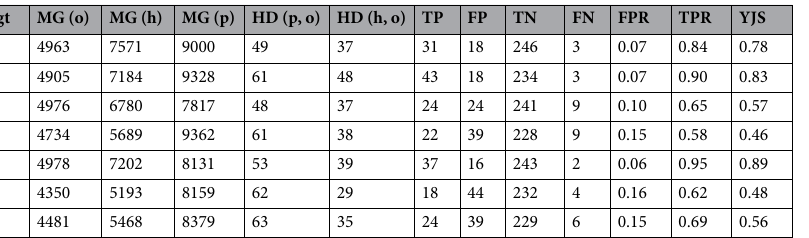
Table 2. Comparison between original, simulated and experimentally humanized sequences. Column 2, 3 and 4 report the MG-score for the original murine sequence “o”, the experimentally humanized sequence “h”, and the one predicted by SD “p”, for each target (column 1). Column 5, 6 report the number of mutations between pairs of sequences (HD). We define as “positive” (P) the mutations of the predicted sequence with respect to the murine one: P = HD (p, o); “negative” (N) the number of corresponding identical residues in the predicted and murine sequence. Accordingly, True Positive (TP) will be the number of common mutations, with respect to “o”, shared by “p” and “h”; False Positive (FP) indicates that in the predicted sequence there is a mutation with respect to the murine, but such mutation is not the present in “h” (or it is not the same mutation); True Negative (TN) imply that neither the predicted nor the humanized sequence have mutations, while False Negative (FN) indicates that the humanized sequence present a mutation with respect to the murine, but the predicted sequence does not. Schematically, being A, B, C possible aminoacids for the triplet (murine, humanized, predicted), we have: (A, A, A) → TN; (A, A, B), (A, B, C) → FP; (A, B, A) → FN; (A, B, B) → TP; thus, HD (p, h) = FP + FN. The True and False Positive Rates are defined as TPR = TP/(TP + FN); FPR = FP/(TN + FP). The last column is the Youden’s index: see